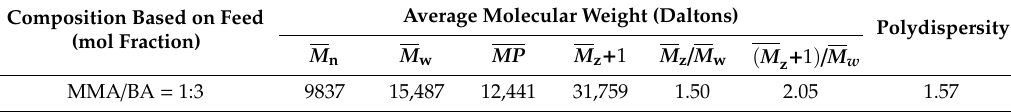
Table 1. The physical properties of the copolymer MMA ‐ BA.